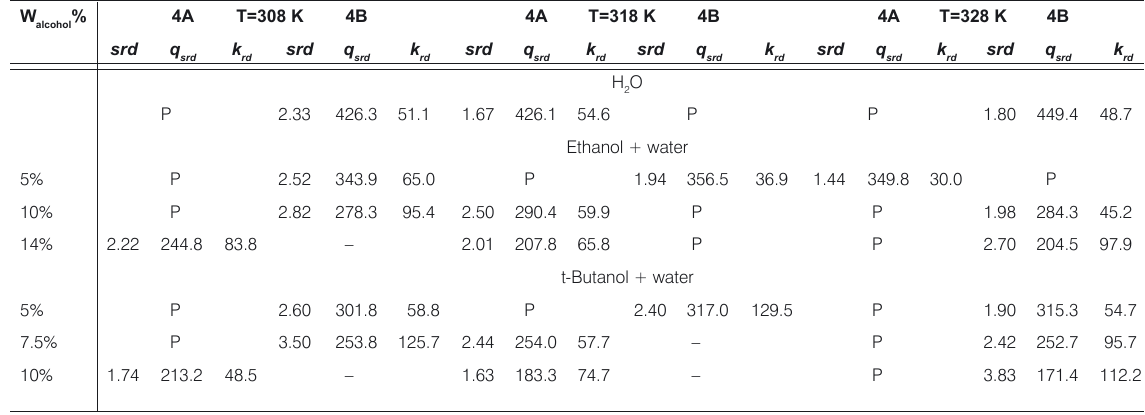
Table 5. Adsorption of TX-100 on silica gel from water and alcohol-water binary mixtures: srd , q desorption isotherm of different sections of region 4 at 308–328